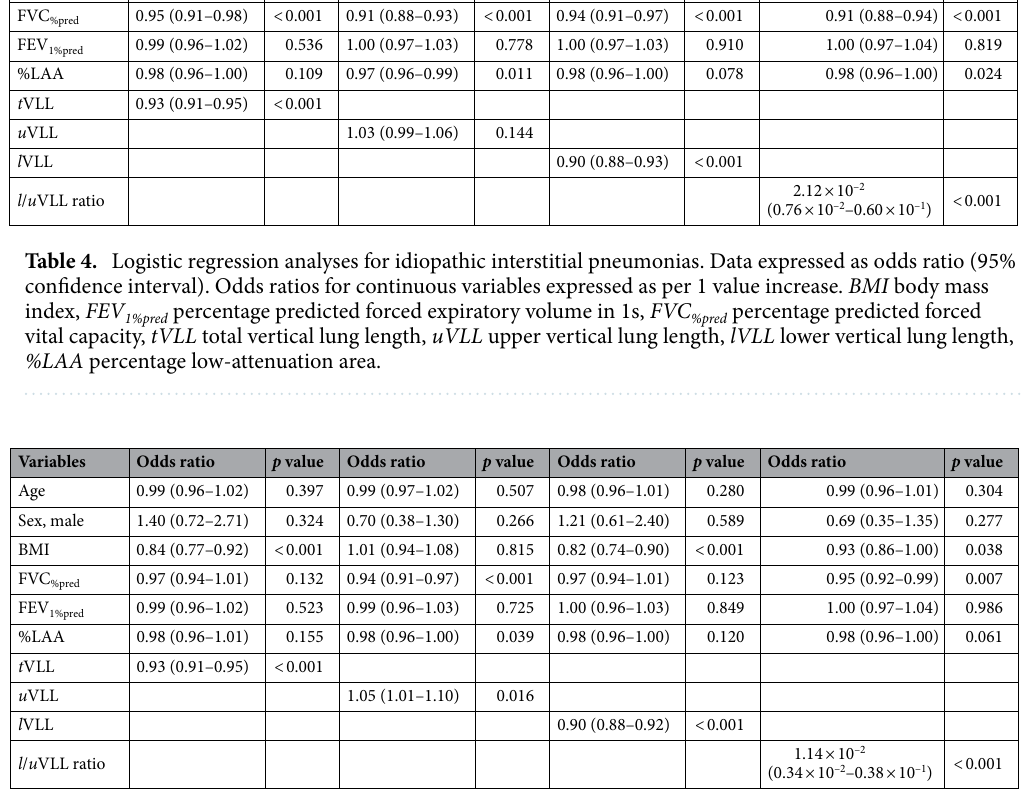
Table 5. Logistic regression analyses for mild idiopathic interstitial pneumonias. Data expressed as odds ratio (95% confidence interval). Odds ratios for continuous variables expressed as per 1 value increase. BMI body mass index, FEV 1%pred percentage predicted forced expiratory volume in 1s, FVC %pred percentage predicted forced vital capacity, tVLL total vertical lung length, uVLL upper vertical lung length, lVLL lower vertical lung length, %LAA percentage low-attenuation